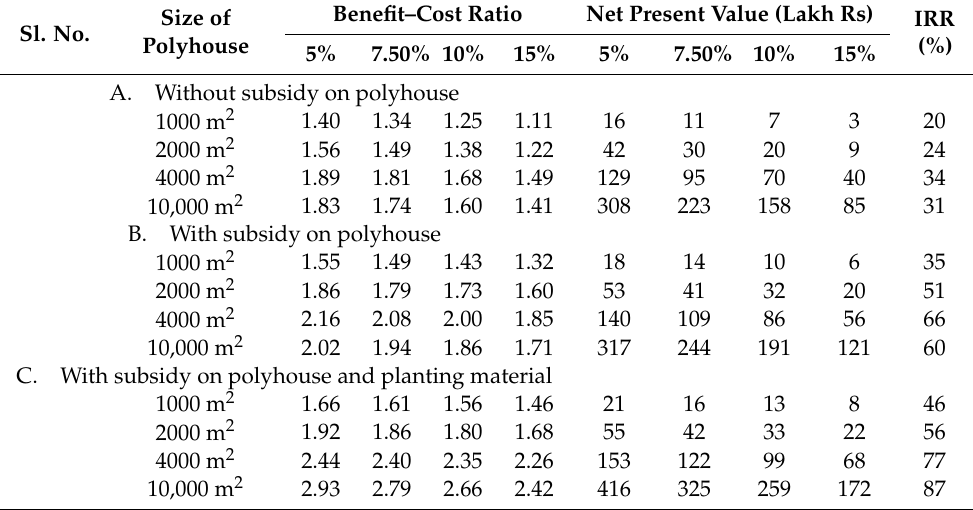
Table 19. Marketing channel followed by the farmers of Almora for cultivation and sale of vegetables under polyhouses. Marketing channel I Producer